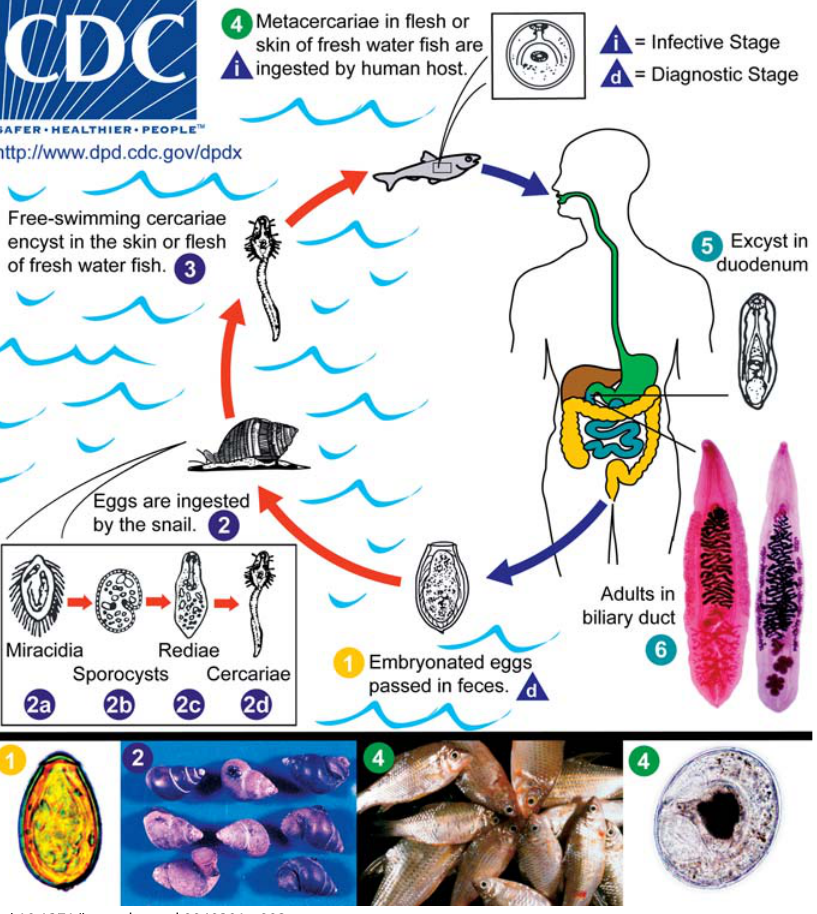
Figure 2. Life Cycles of O. viverrini and C. sinensis Embryonated eggs are discharged in the biliary ducts and in the stool (1). Eggs are ingested by a suitable snail intermediate host (2); there are more than 100 species of snails that can serve as intermediate hosts. Each egg releases a miracidium (2a), which goes through several developmental stages (sporocyst [2b], redia [2c], and cercaria [2d]. The cercaria is released from the snail and after a short period of free-swimming time in water, it penetrates the fl esh of a freshwater fi sh, such as Cyclocheilichthys armatus or Puntius leiacanthus , where it encysts as a metacercaria (3). Humans are infected through ingestion of undercooked, salted, pickled, or smoked freshwater fi shes (4). After ingestion, the metacercaria excysts in the duodenum (5) and ascends the biliary tract through the ampulla of Vater. Maturation to adulthood (right, O. viverrini ; left, C. sinensis ) takes approximately one month (6). The adult fl ukes (measuring 10–25 mm by 3–5 mm) reside in the small and medium-sized biliary ducts. In addition to humans, carnivorous animals can serve as reservoir hosts. (Adapted from